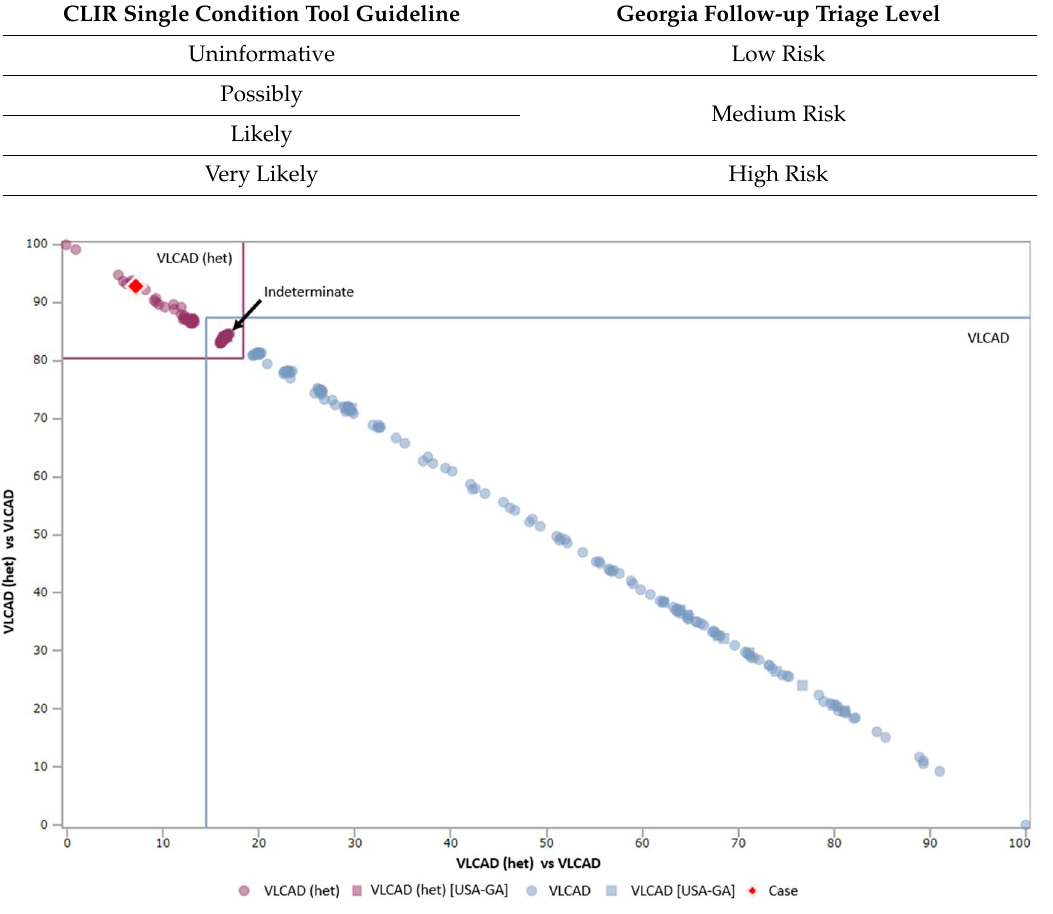
Figure 1. Dual scatter plot for very long chain acyl-CoA dehydrogenase (VLCAD) vs. VLCAD (heterozygous) designed to reduce false positive (FP) NBS results due to biochemical profiles in carriers. The upper left corner is confirmed VLCAD carriers cases. The bottom right corner is confirmed true positive (TP) cases of VLCAD deficiency. The square in the middle is an indeterminate zone where carriers cannot be distinguished from TP cases. In this example, the red diamond represents the screening case, and is classified as most likely a carrier. Access date: 2020/01/09.